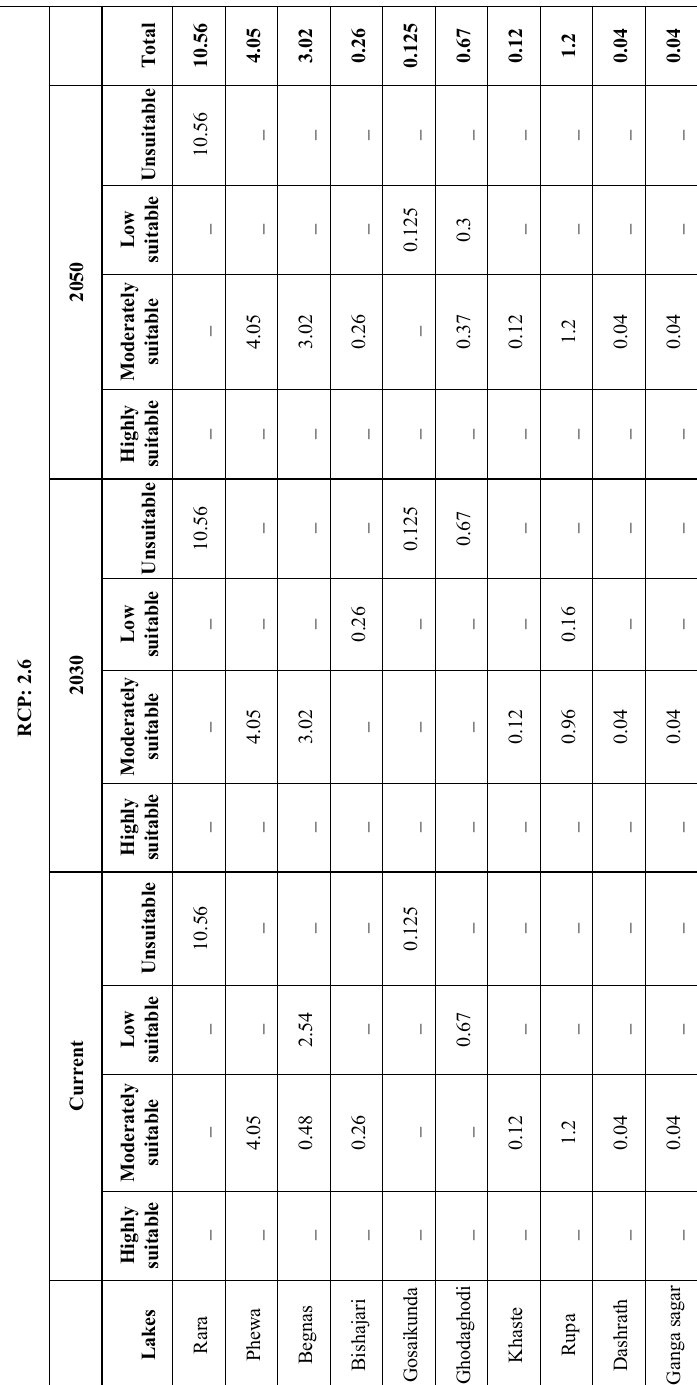
Table 4. Potential Area of Water Hyacinth in the lakes in current and future scenarios under